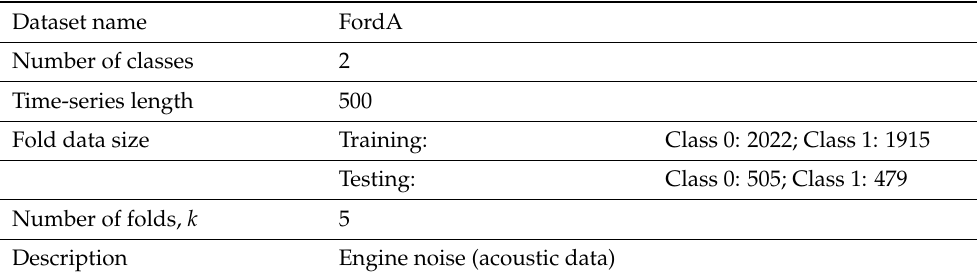
Table 4. Configuration of the k -fold cross-validation experiment with the FordA data from the UCR Time Series Classification